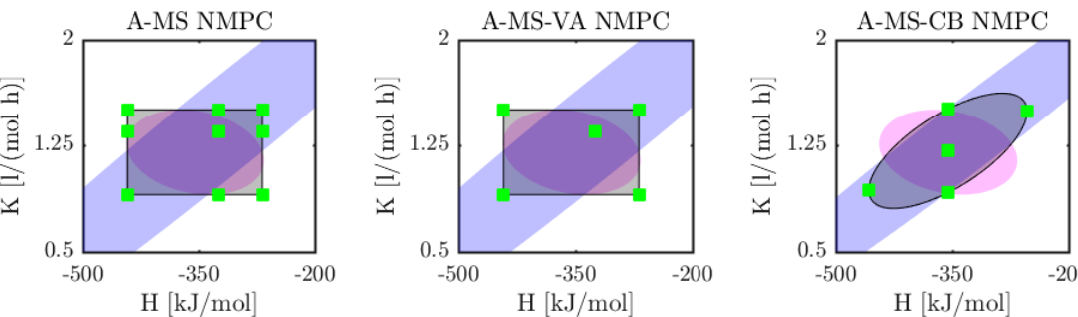
Figure 7. Confidence regions of the uncertain parameters considered in the adaptive NMPC variants at t = 0.05 h. represents the initial confidence region, represents the confidence region obtained using the observed measurements, represents the confidence region that is considered by the adaptive NMPC schemes and represents the parameter combinations that are used to build the scenario tree of the adaptive NMPC